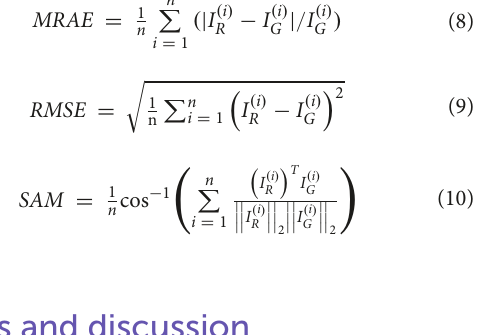
the reconstructed multispectral images, and I G represents the ground-truth multispectral